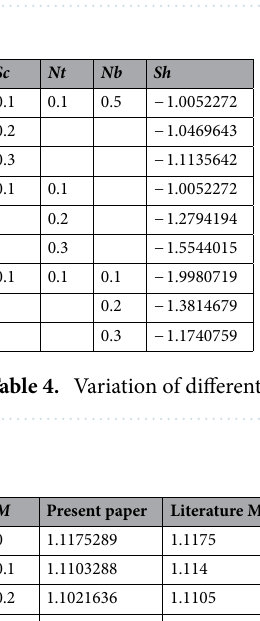
Table 3. Variation of different parameter on Nusset number.